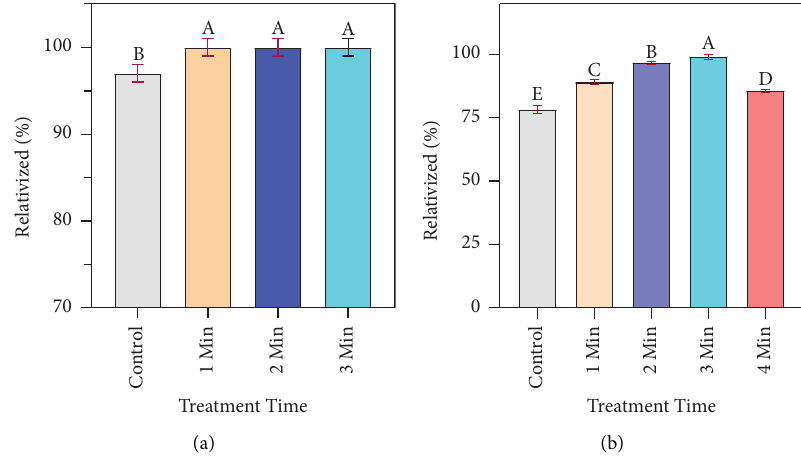
Figure 6: Infuence of CAPP exposure on the relativized germination of (a) radish and (b)